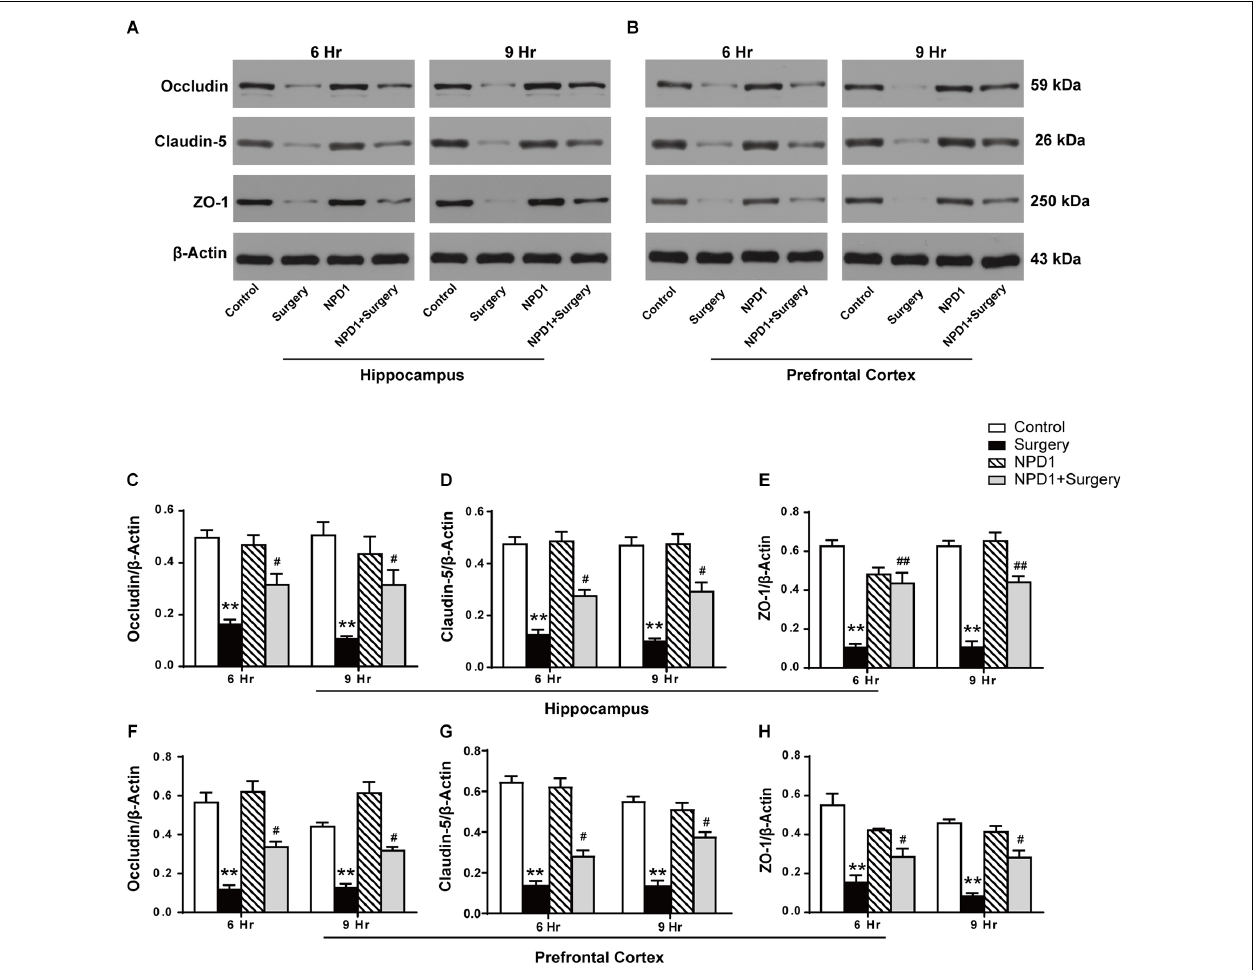
FIGURE 4 | NPD1 modulates the expression of tight junction (TJ)-associated proteins in the hippocampus and prefrontal cortex after surgery. Representative Western blotting bands of the expression of occludin, claudin-5, and ZO-1 in the hippocampus and prefrontal cortex at 6 and 9 h after surgery (A,B) . Quantification analyses of the expression of occludin, claudin-5, and ZO-1 were normalized to that of β -actin as internal control (C–H) . Data are presented as mean ± SEM. Statistics: two-way ANOVA followed by Bonferroni post hoc comparison. (C–H) n = 4–5 per group. ** P < 0.01 vs. the control group, # P < 0.05 vs. the surgery group, ## P < 0.01 vs. the surgery